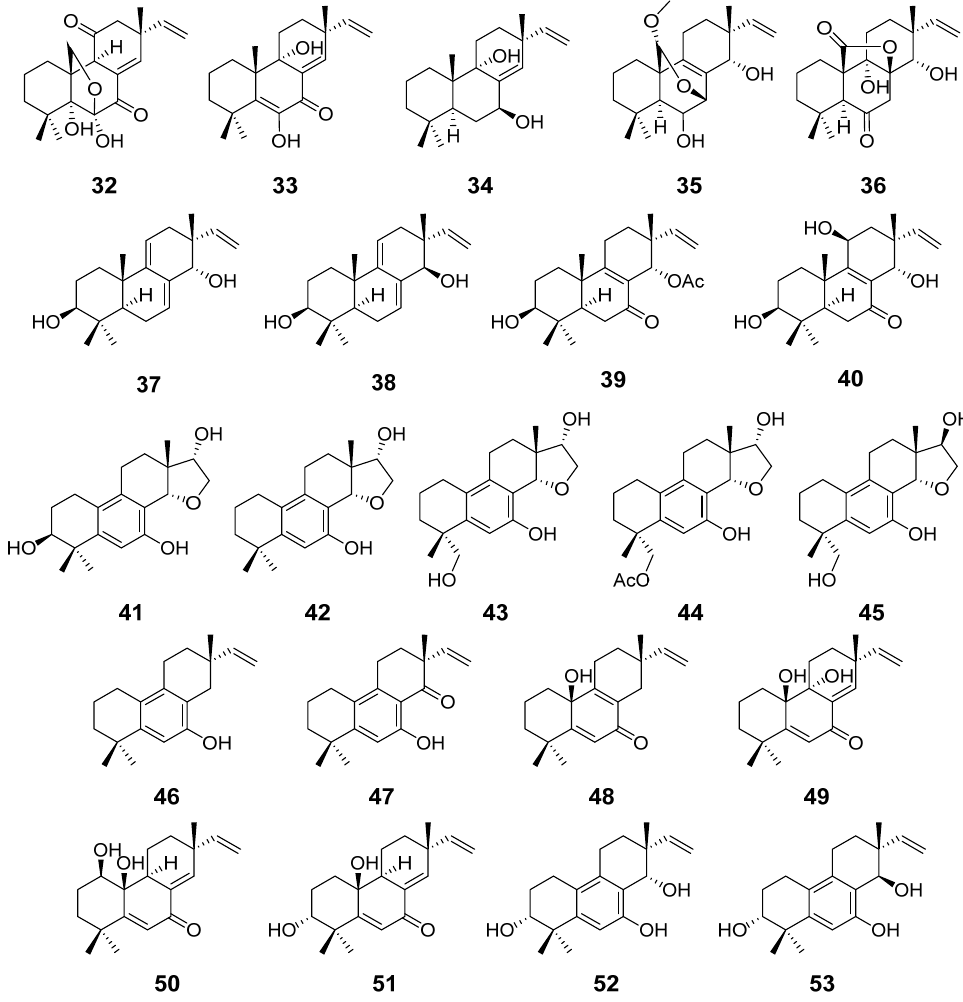
Figure 4. Structures of compounds 32 – 53 .